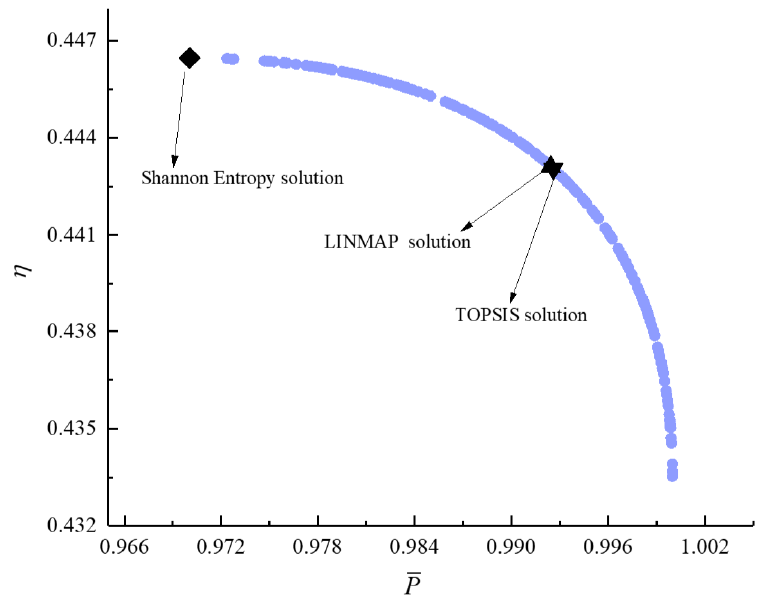
Figure 15. Bi-objective optimization on P − η .